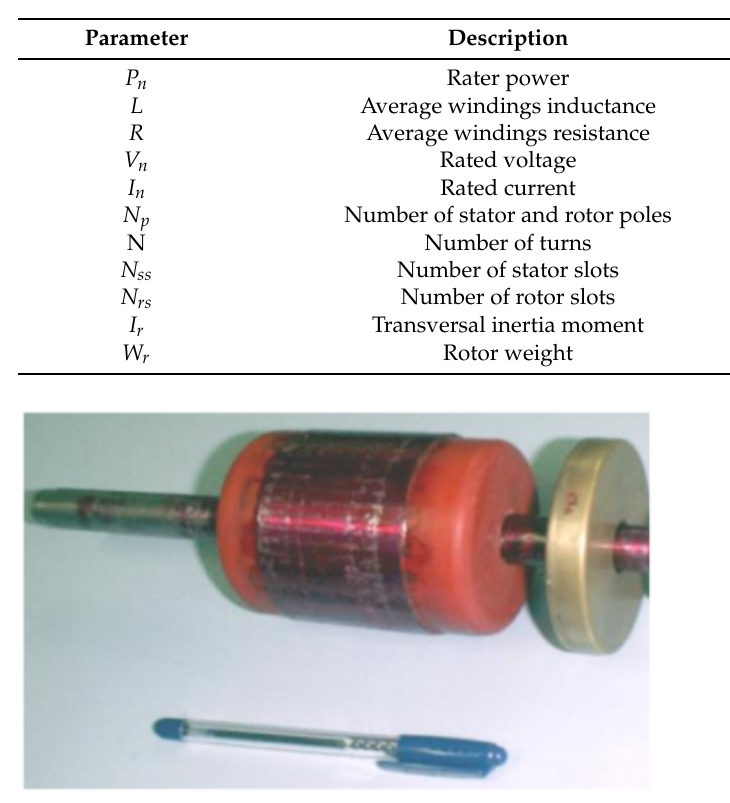
Figure 7. Rotor image.